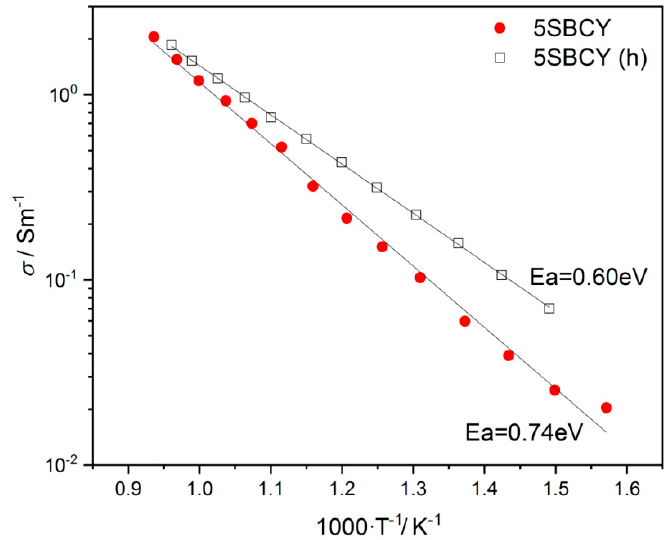
Figure 13. Variation σ vs 1000 / T recorded for the 5SBCY sample before or after additional exposure in 5 vol.% H 2 O in Ar (h).